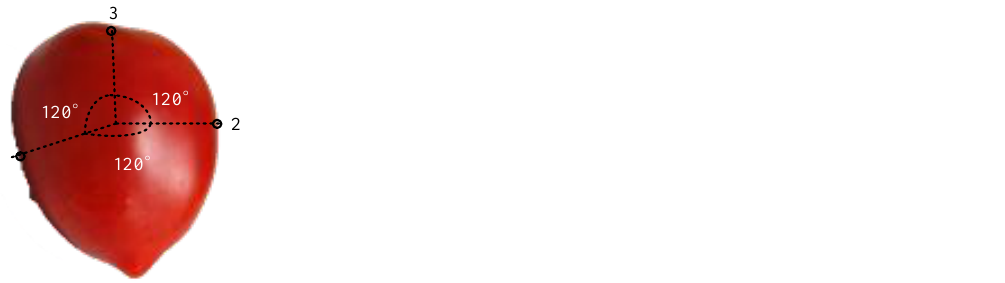
Table 7. The parameters of the experimental